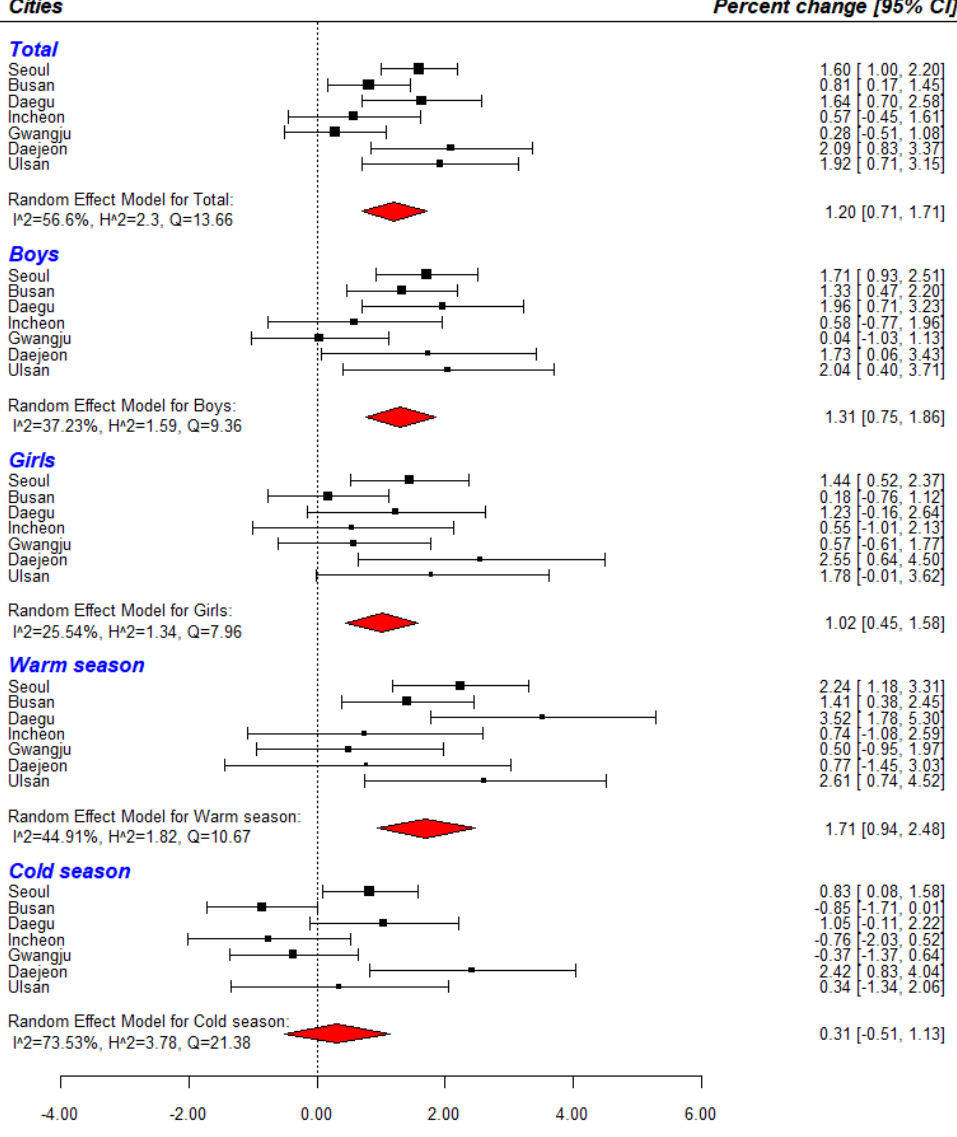
Figure 3. Meta-analysis of the association between PM 2.5 and ALRI hospital admissions in seven major cities in Korea (Percentage change (%) per 10 µ g/m 3 ). All models were used the 7-day moving average exposure to PM 2.5 µ g/m 3 . Time-series model adjusted for same covariates (time, AT, day of weeks)